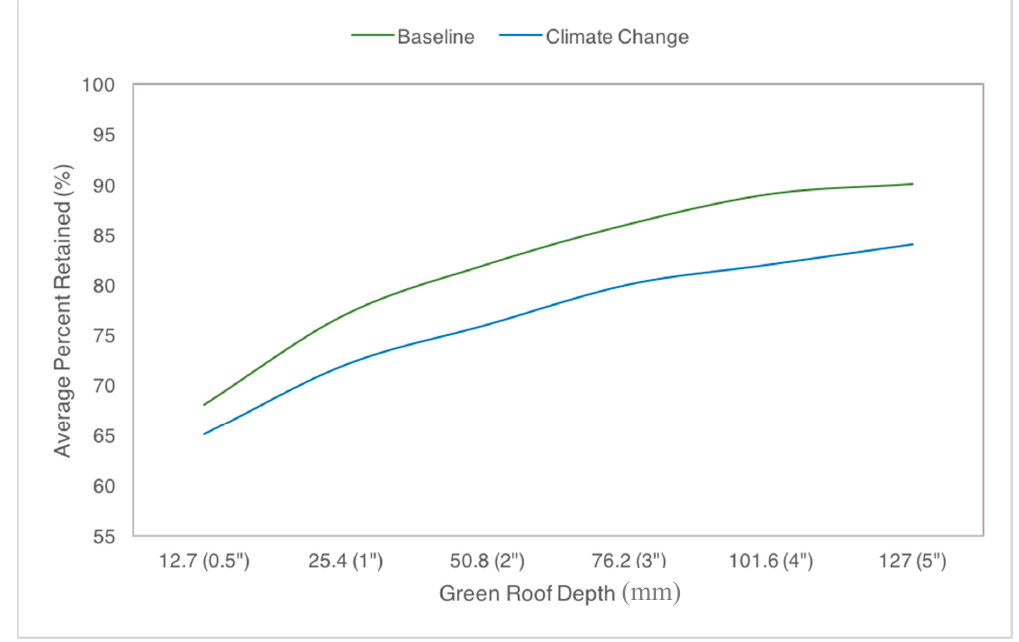
Figure 11. Modeled green roof performance under varying design depths (12.7–127 mm).